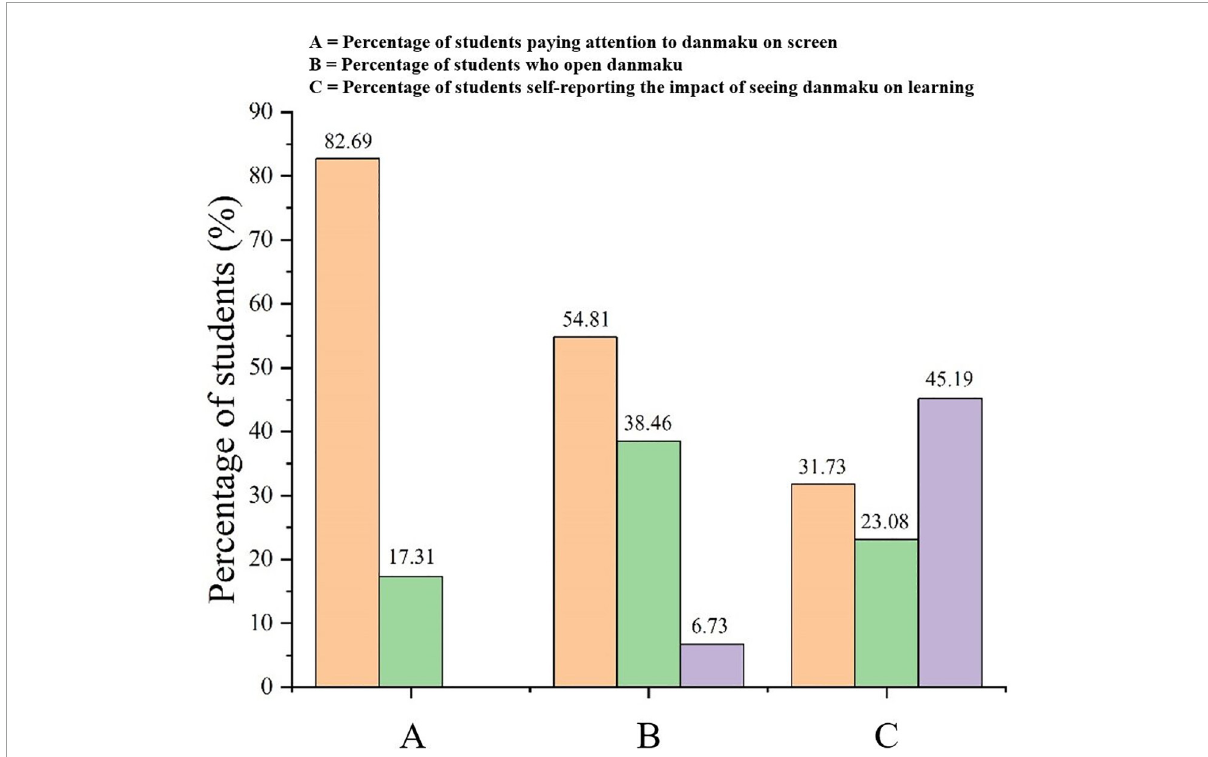
FIGURE2 Learner expectations regarding the impact of viewing danmaku during instructional videos. (A) Differences in intrinsic cognitive load across experimental conditions; (B) differences in extraneous cognitive load across experimental conditions; and (C) differences in cognitive load across experimental